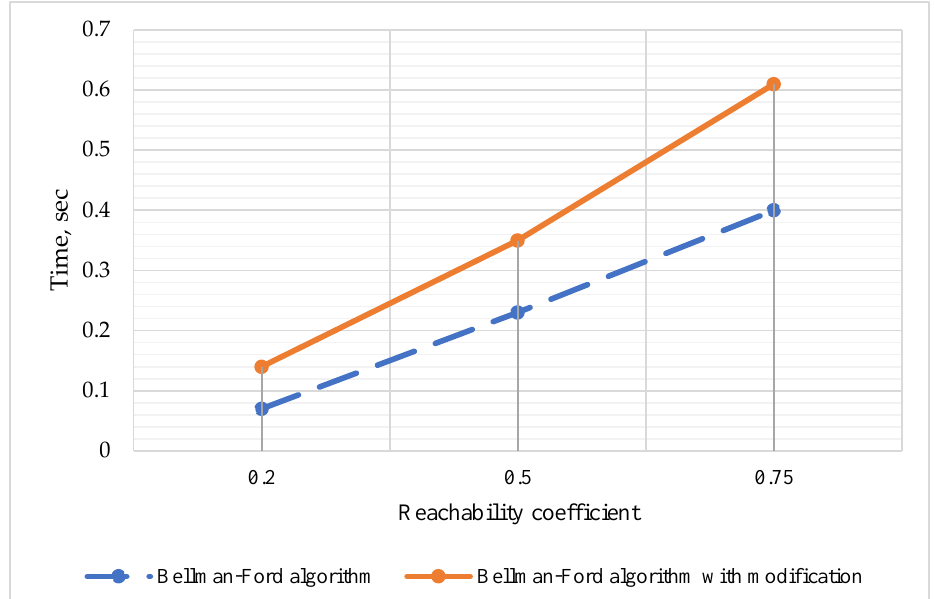
Figure 9 . Dependence of the performance of algorithms on the reachability without construction of feasible routes.